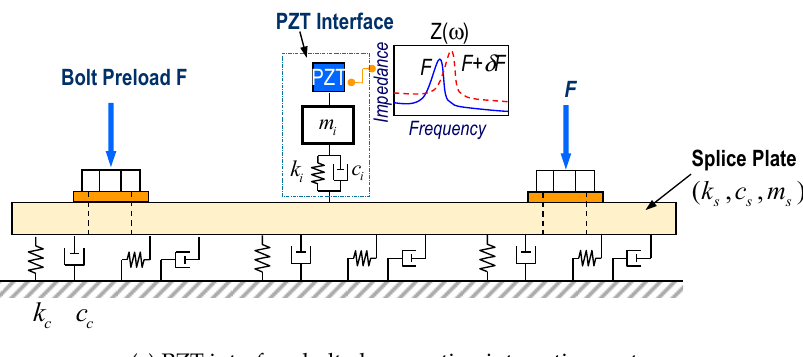
Figure 1. Impedance monitoring method for bolted connection via PZT interface.